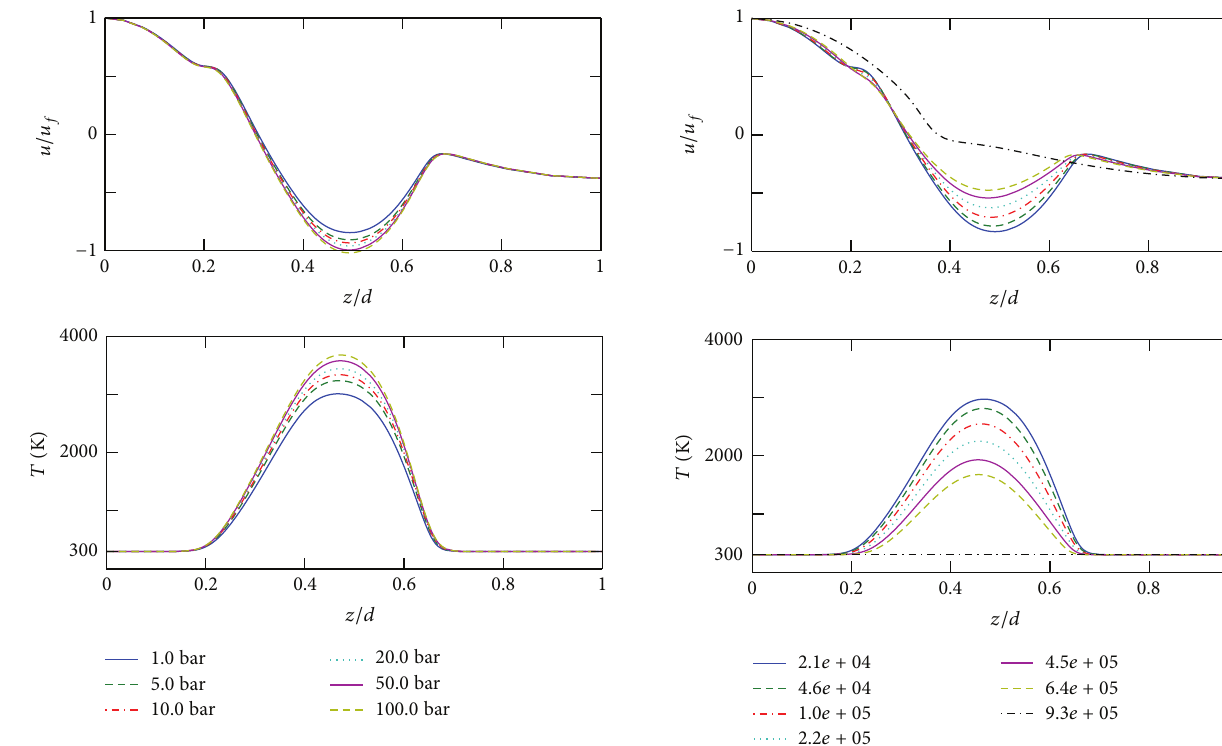
Figure 2: Profiles of the normalized axial velocity 𝑢/𝑢 𝑓 and the temperature 𝑇 over the normalized grid 𝑧/𝑑 for selected pressures of the hydrogen-oxygen flame.